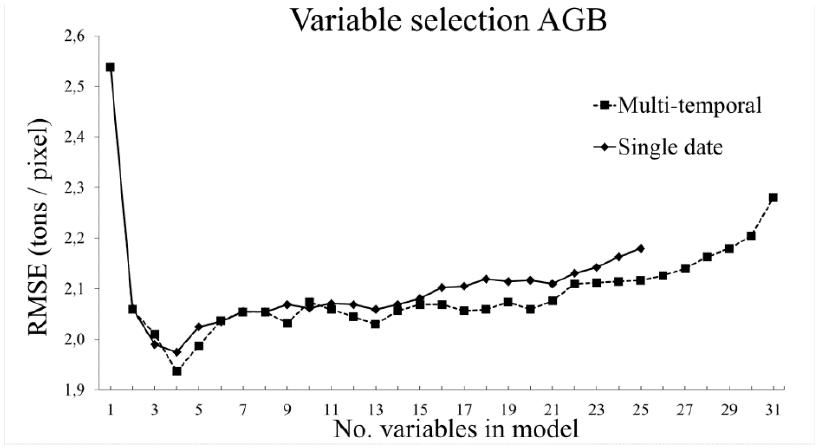
Figure 5. Identification of the optimal number of predictor variables for predicting aboveground biomass (AGB) using backward elimination. The root mean square error (RMSE) is calculated from the out of bag (OOB)